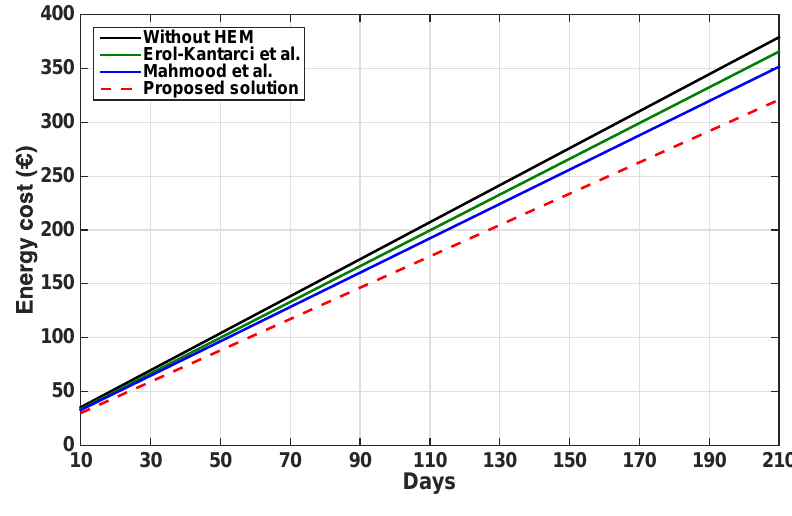
Figure 10. The electricity consumption